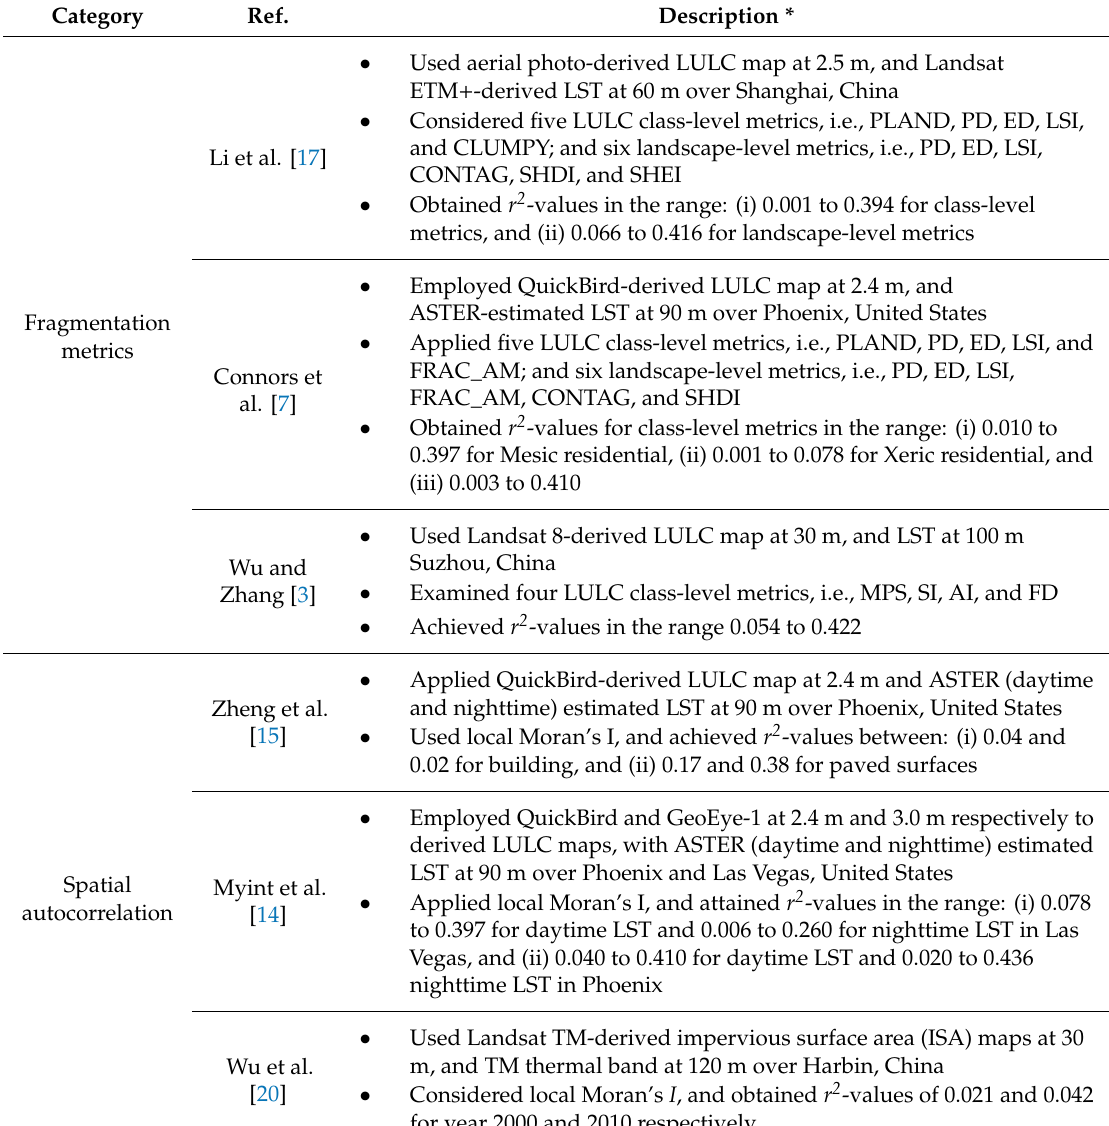
Table 1. Example case studies that explored relations between landscape configuration and LST. Category